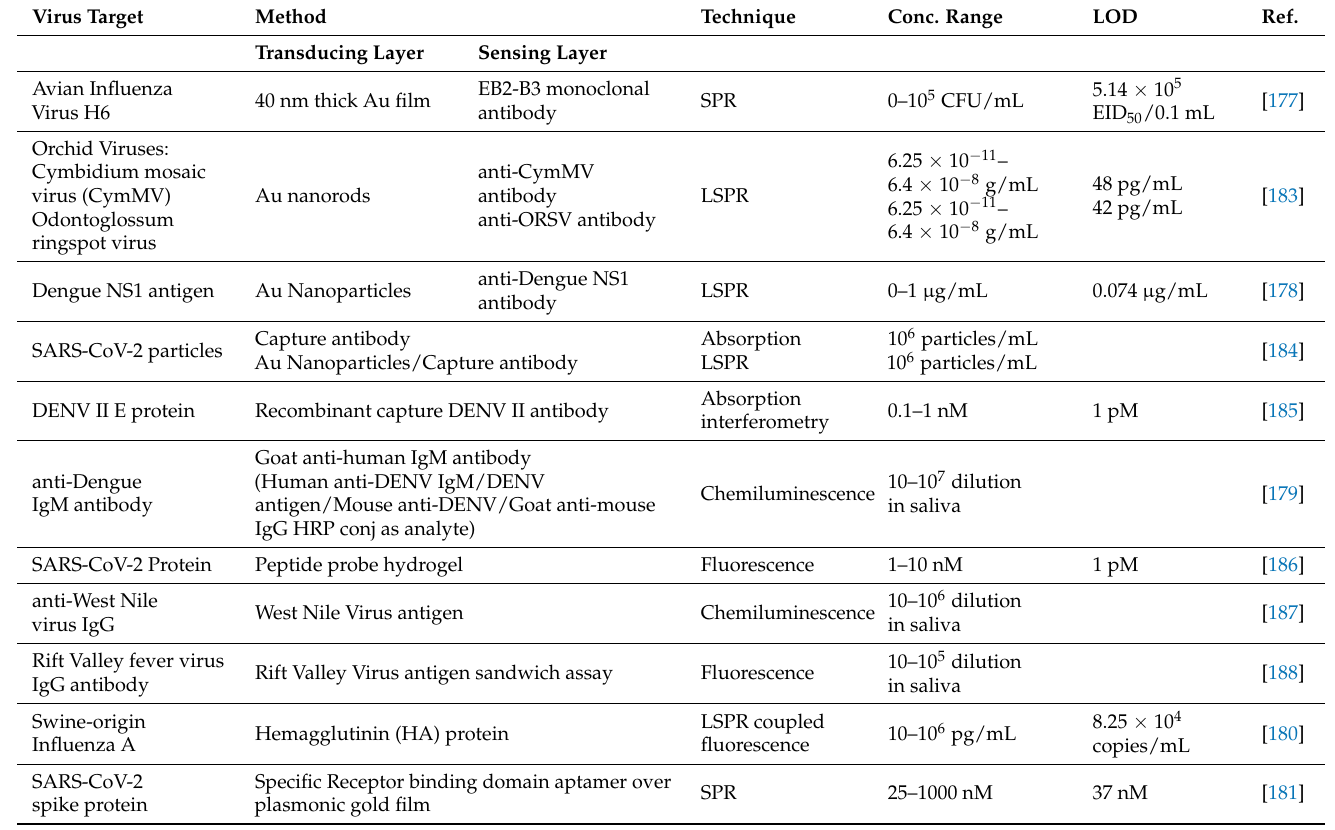
Table 6. A comparison of various viral sensors using fiber optic